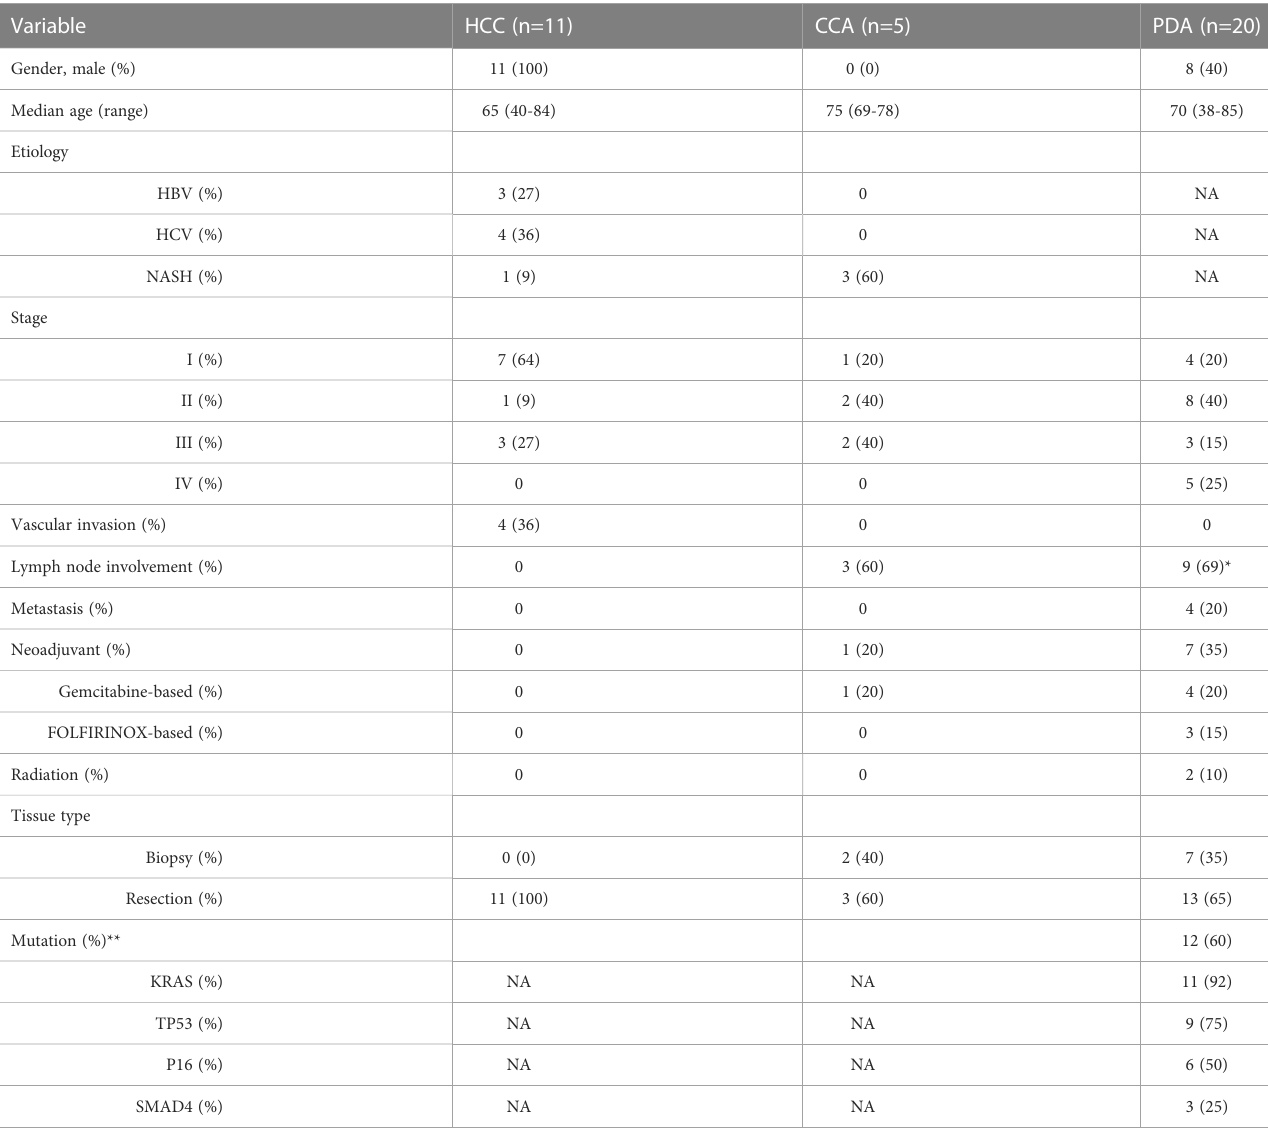
TABLE 1 Patient clinical characteristics and